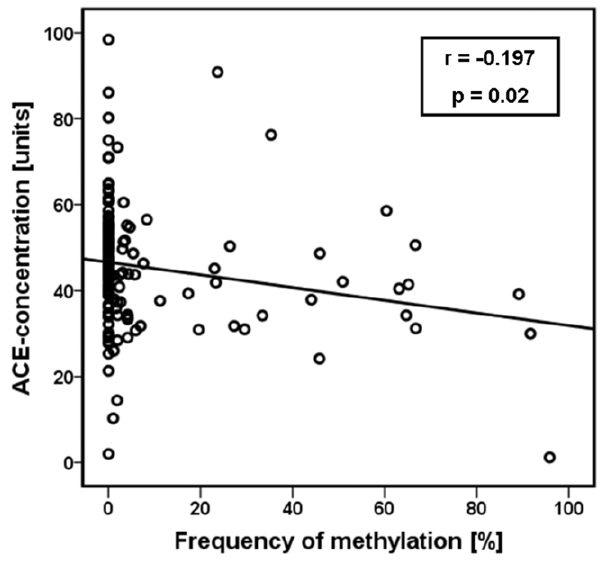
Figure 4. Correlation analysis between the ACE serum concen- trations (baseline) and the ACE methylation frequency over all 24 CpG sites of each probe. We found a significant inverse correlation in the total sample (r= 2 197, p=0.02; Pearson’s correlation).